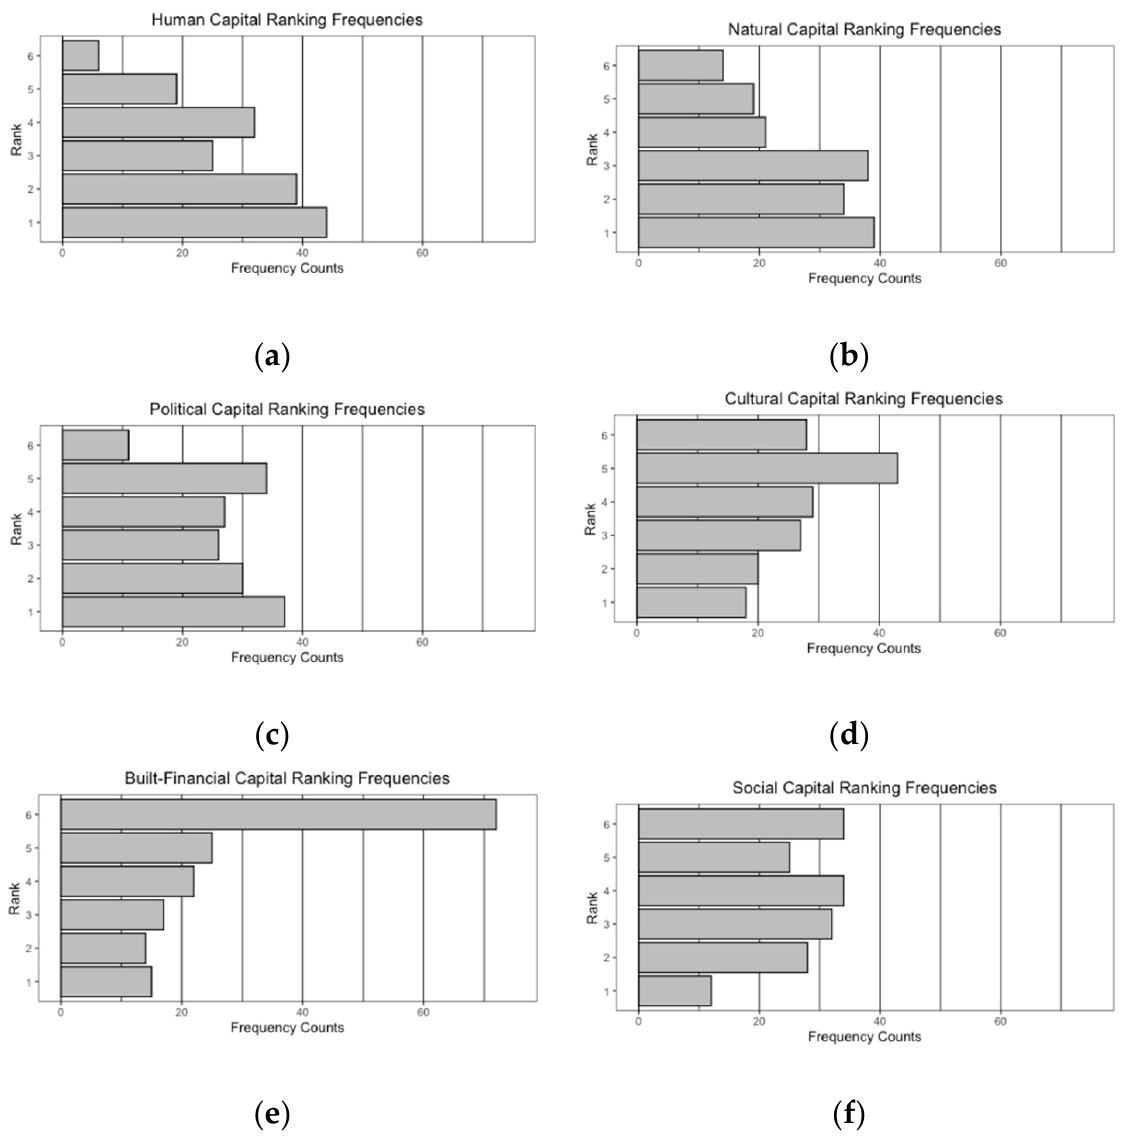
Figure 2. Absolute Frequency Distributions for Community Capital Ranking Data: ( a ) Human; ( b ) Natural; ( c ) Political; ( d ) Cultural; ( e ) Built–Financial; ( f ) Social. Table 3. Community Capital Borda Counts.